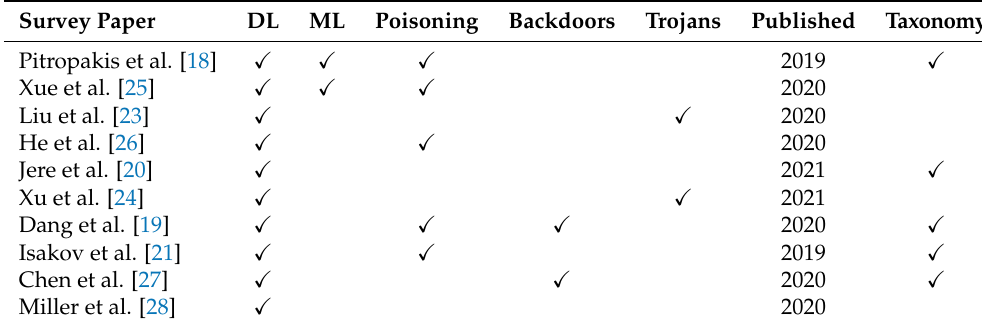
Table 1. Summaries of the related publications of survey papers in the dataset that focus on or include poisoning or backdoor attacks in deep